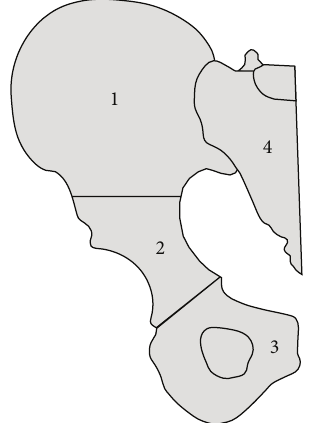
Figure 1: Anatomic regions of the pelvis according to the Enneking